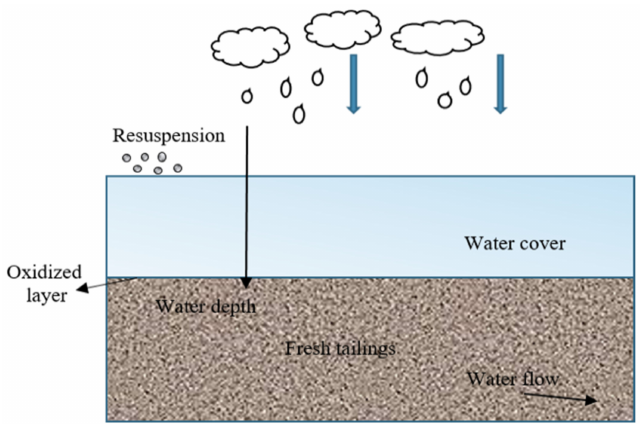
Figure 2. Schematic diagram of flooded cover system [22]. (Note: the thick arrow represents rainfall; the long arrow indicates the depth of water cover; the arrow on the left indicates the extension of the oxidized layer; the arrow on right indicates the runoff direction of water in the fresh tailing.) This picture was adapted from [22] with permission from publisher Elsevier in May